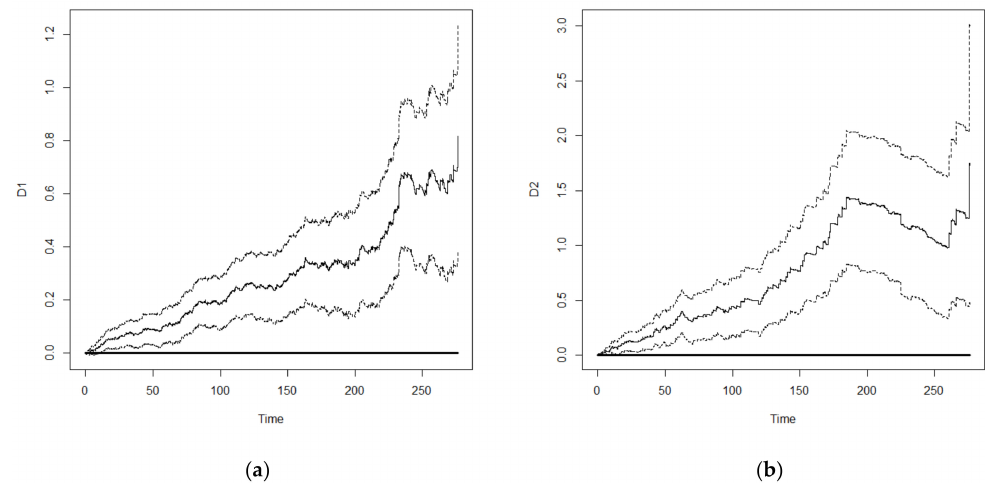
Figure 4. Cumulative regression coefficient and 95% confidence interval: ( a ) Common physical function; ( b ) Poor physical